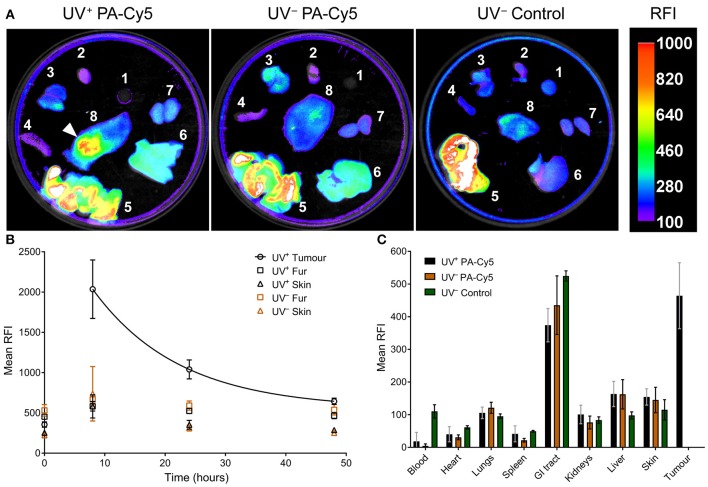
PA-Cy5 tumor uptake is significantly higher than healthy tissues. UV+ tumor bearing and UV− control mice were euthanized 48 h post injection of PA-Cy5. The major organs from each animal were optically imaged using 630 nm excitation and 700 nm emission (A). Organs were also imaged from UV− mice that were not administered PA-Cy5 (UV− Control) for autofluorescence comparison. 1. Blood, 2. Heart, 3. Lungs, 4. Spleen, 5. GI tract, 6. Liver, 7. Kidneys, and 8. Dorsal skin. A white arrow indicates the tumor region. Calibration bar represents relative fluorescence intensity (RFI). Fluorescence data is overlaid on X-ray images. Tumor, fur, and skin regions of interest were identified to determine mean RFI for UV+ HPV38E6E7-FVB tumor bearing mice (n = 5) and UV− HPV38E6E7-FVB control mice (n = 6) intravenously injected with PA-Cy5 (B). The mean RFI is plotted against time, with an exponential decay curve fit to the tumor data (solid line). Regions of interest were identified using reflectance images (white light) to prevent fluorescence bias. Error bars represent the standard deviations of the mean. 48 h after the injection of PA-Cy5 the animals were sacrificed, tumors and organs were removed and optically imaged (C). Columns represent the mean RFI and the error bars represent standard deviations. One-Way ANOVA analysis resulted in significant differences (P < 0.0001) between the tumor and blood, heart, lungs, spleen, kidneys, liver, and skin within the UV+ PA-Cy5 group. Two-way ANOVA analysis resulted in no statistically significant differences between the UV+ PA-Cy5 and UV− PA-Cy5 blood, heart, lungs, spleen, GI tract, kidneys, liver, or skin fluorescence.